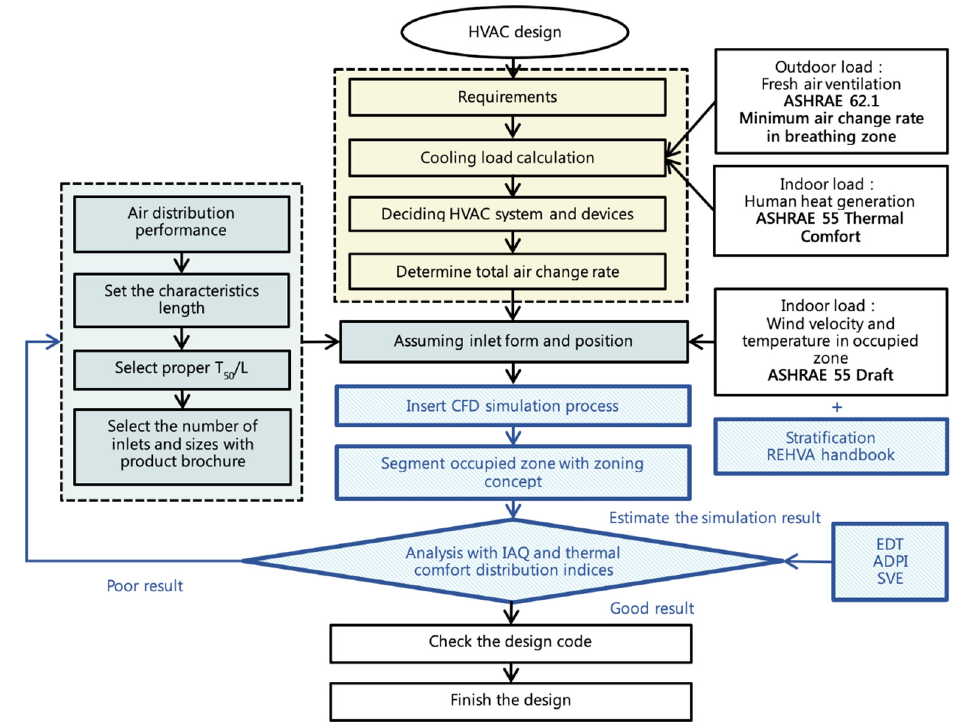
Figure 6. Improved HVAC system design strategy based on building performance simulation.